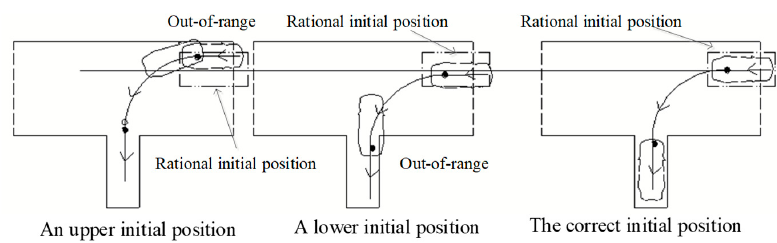
Figure 3. The initial position affecting trajectories of reverse parking.